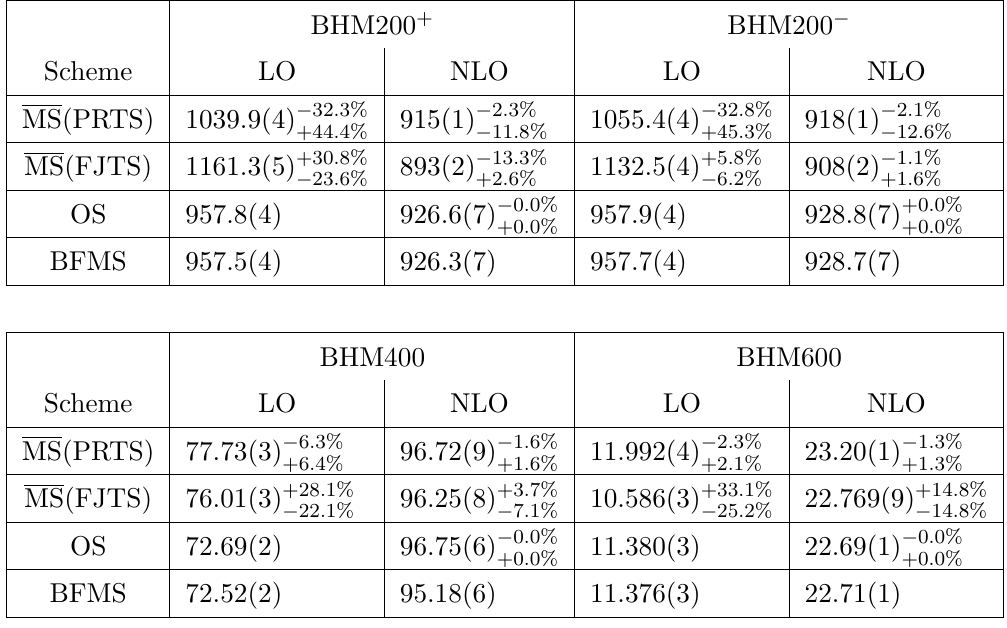
Table 10 . As in table 9, but for the cross section (cid:27) [fb] of heavy Higgs-boson production in Higgs-strahlung, pp H 1 (cid:22) + (cid:23) (cid:22) + X , in the !